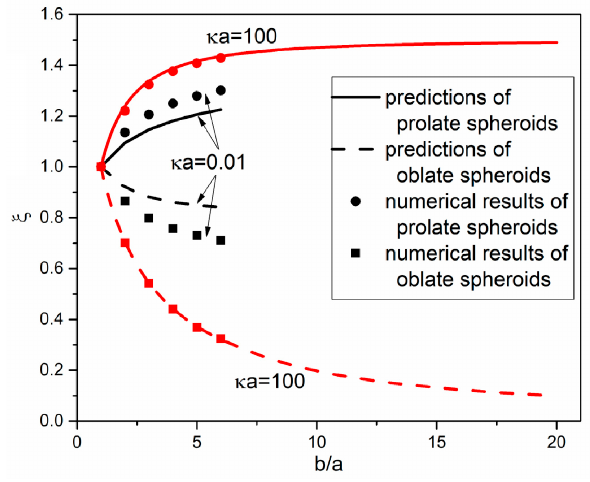
Figure 6. Comparison of thermodiffusion coefficient ratios ξ among the numerically computed results and the results calculated from Equations (20) to (23) for prolate and oblate particles, when b / a is in the range of 1 to 20 under two values of a κ ( 0.01 a κ = and 100 ).